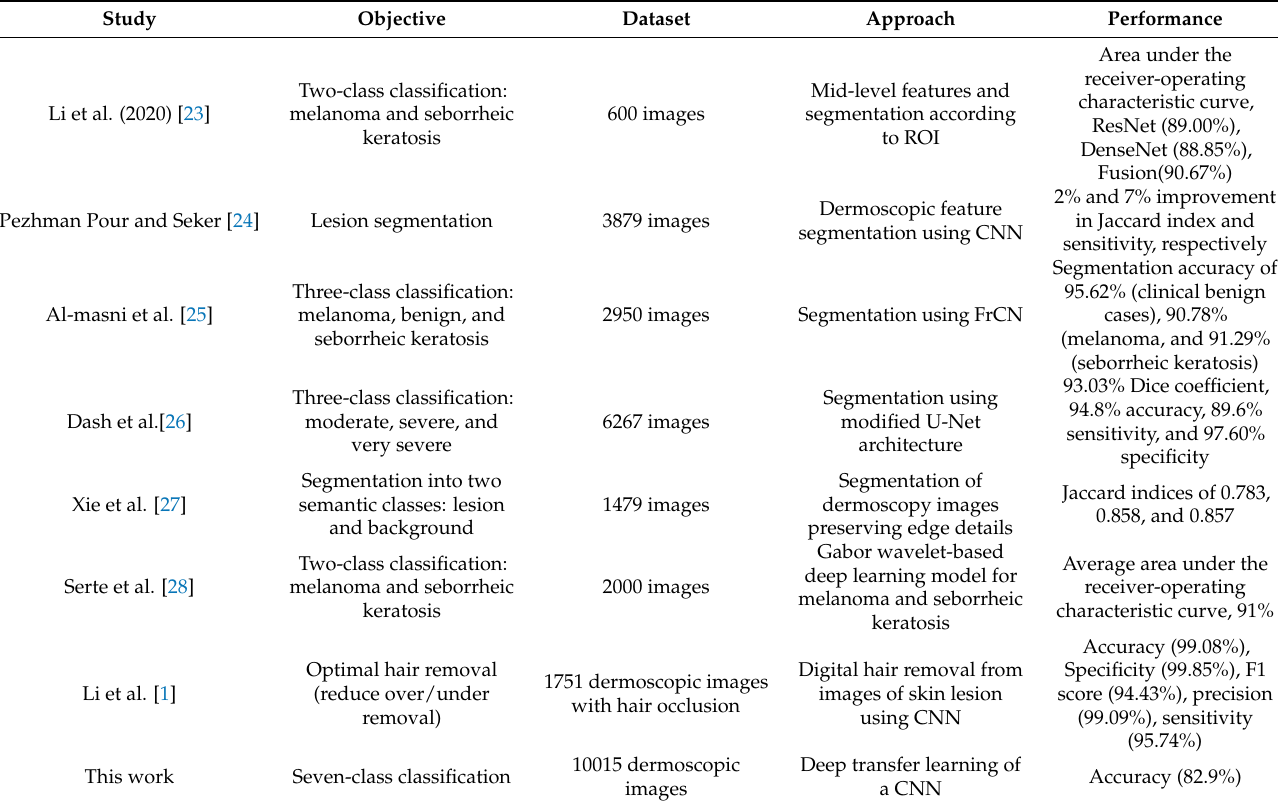
Table 5. A summary of the latest literature in automatic skin lesion